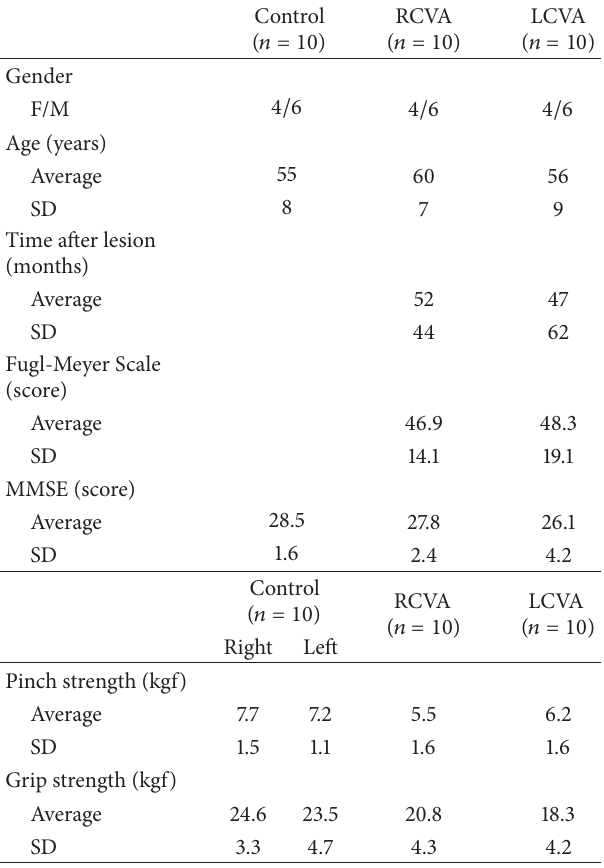
Table 1: Demographic and clinical data of the left and right poststroke hemiparesis and control